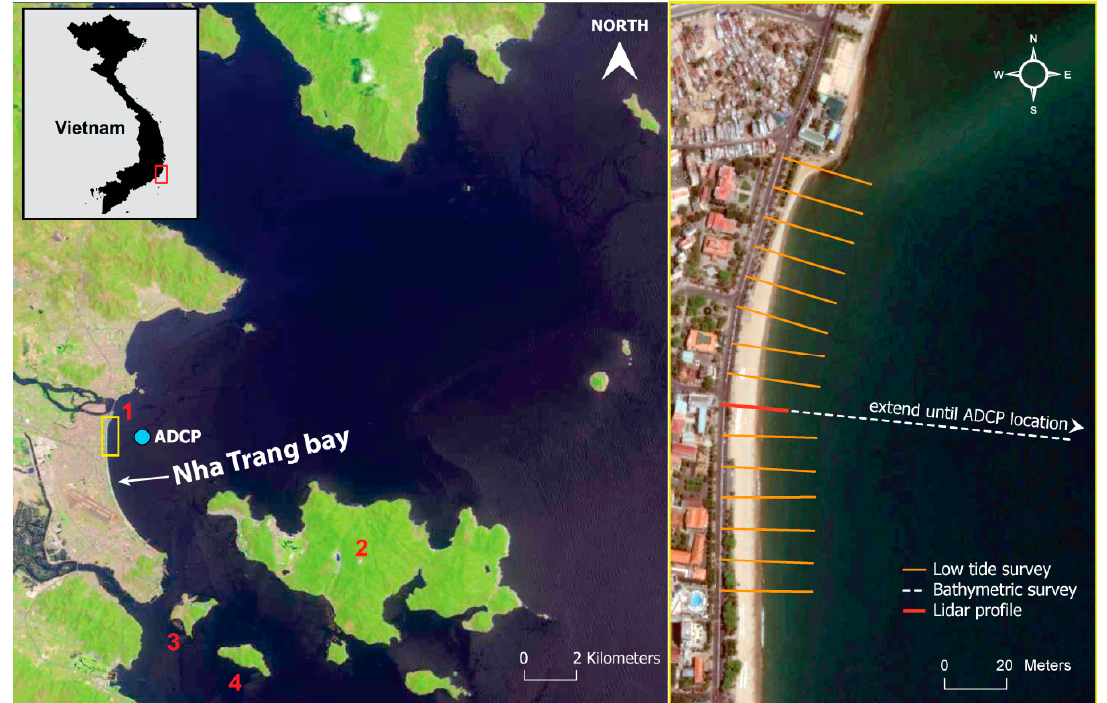
Figure 1. Left: Location of Nha Trang bay and some important local features including: 1—Cai estuary; 2—Hon Tre island; 3—Hon Mieu island; 4—Hon Tam island. The yellow box indicates the section of the beach selected for this experiment (zoomed in the right panel). Right: Aerial photograph of the study site in which orange lines indicate the 15 cross-shore transects where topographic surveys were performed every low tide; in red is the profile where instruments were installed (right panel).